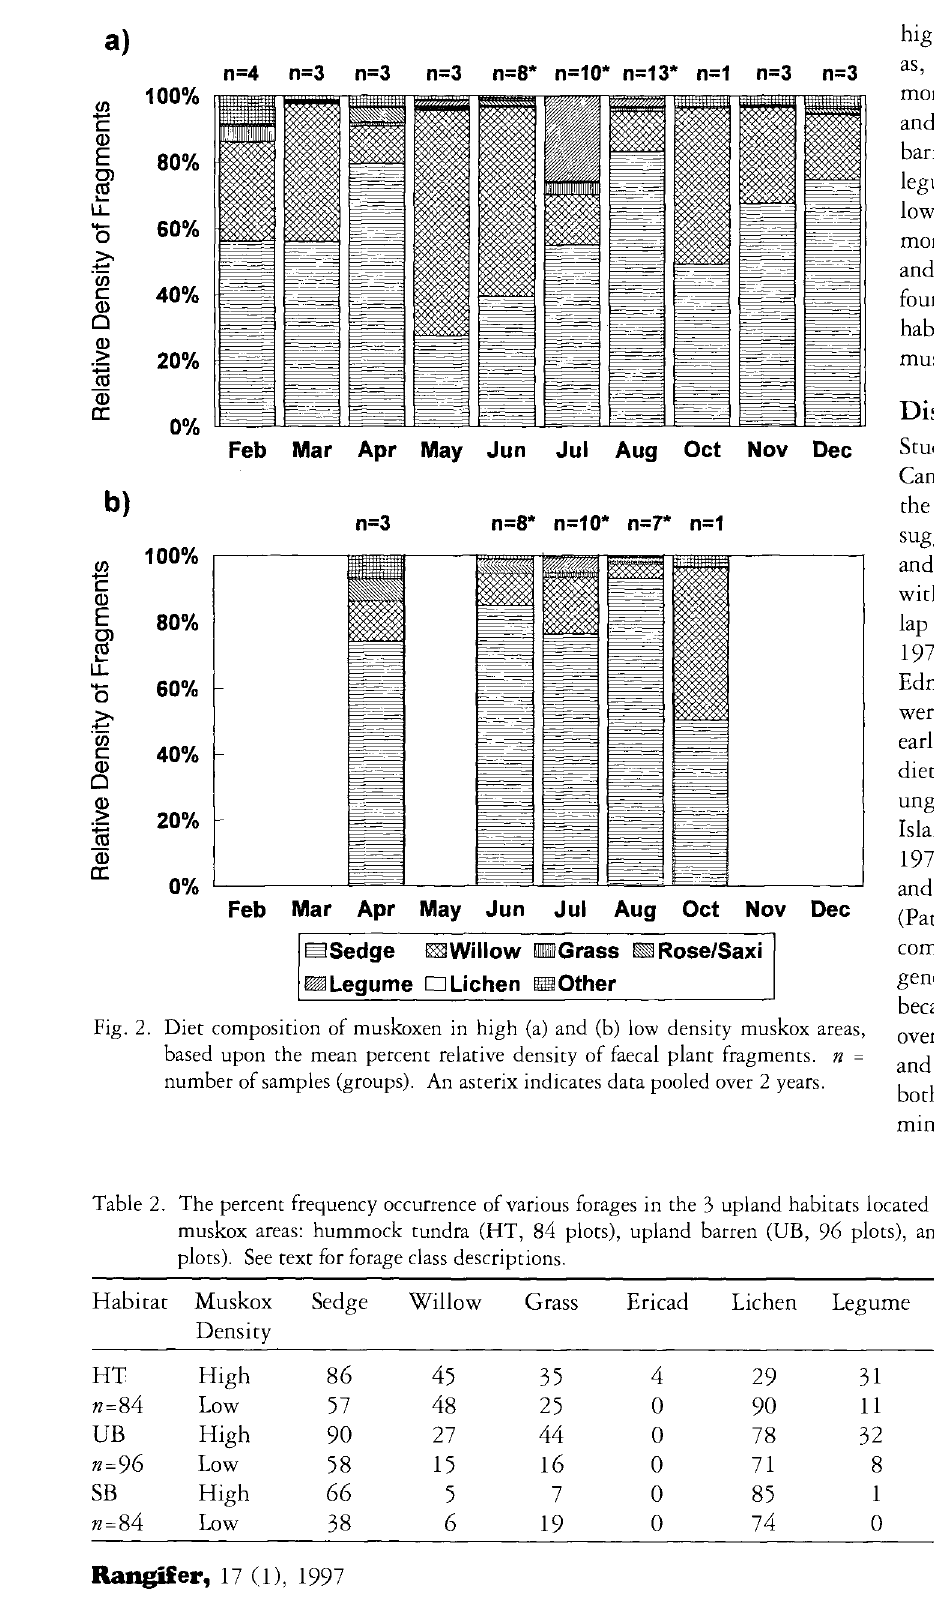
Table 2. The percent frequency occurrence of various forages in the 3 upland habitats located in high and low density muskox areas: hummock tundra (HT, 84 plots), upland barren (UB, 96 plots), and stony barren (SB, 84 plots). See text for forage class